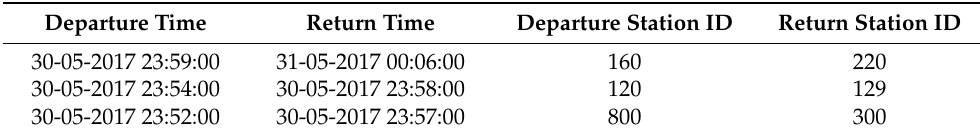
Table 3. Example of the data generated for each